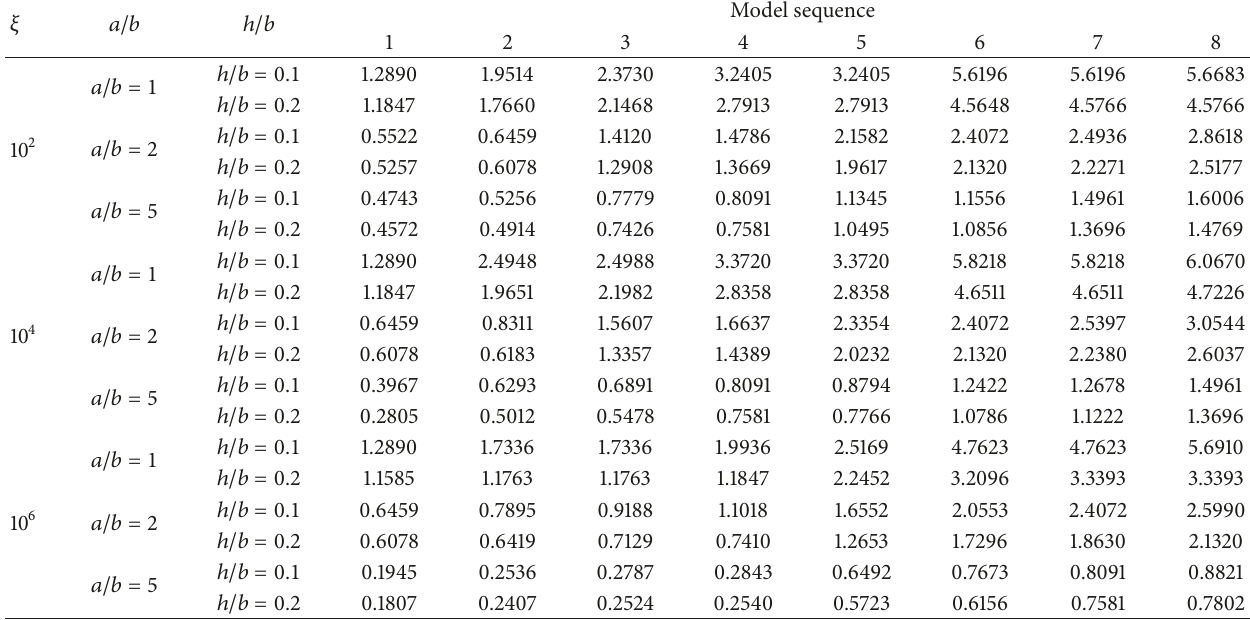
Table 4: Frequency parameters Ω = 𝜔𝑏 2 (𝜌ℎ/𝐷) 1/2 /𝜋 2 for the restraining stiffness point support plate with different geometry parameters, 𝜉 = 𝜉 = 𝜉 , 𝜉 = 0 , for each point 𝑘 𝑖 𝐾 𝑖 𝐾 𝑖𝑗